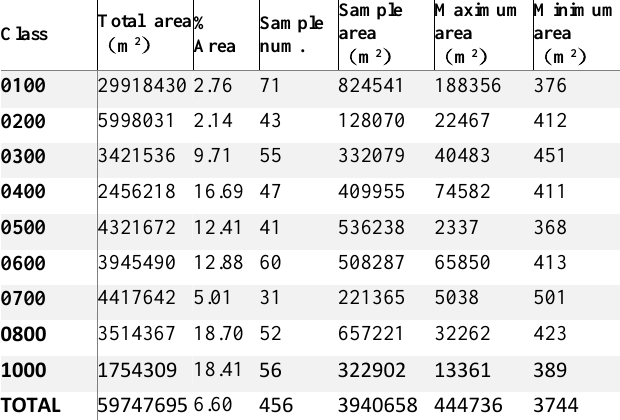
Table 1. Distribution of classes based on the area, number of objects, maximum and minimum